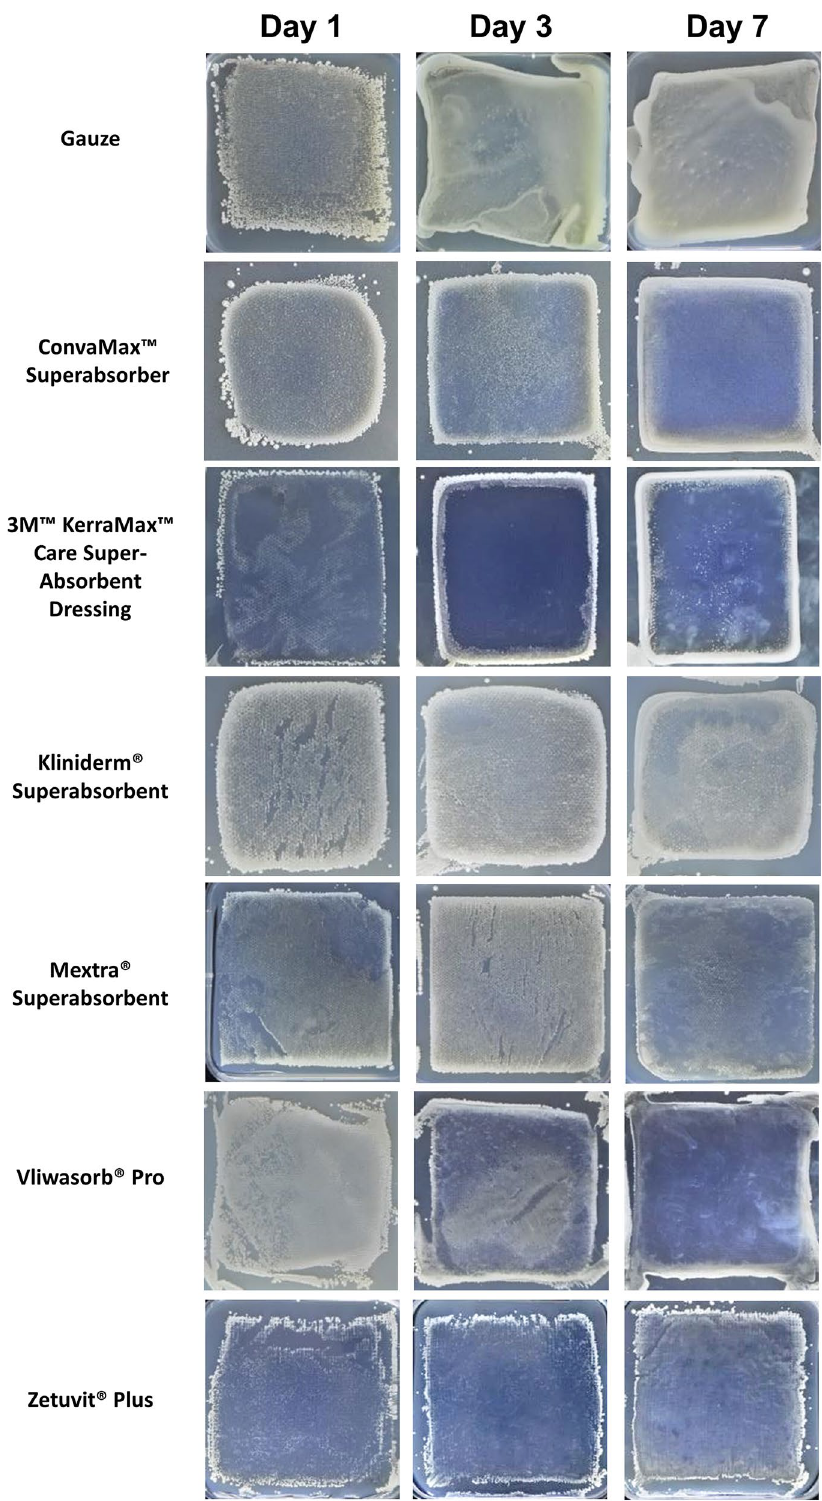
Figure 2. Bacteria transferred to surfaces by superabsorbent dressings. Superabsorbent wound dressings were inoculated with ~ 1 * 10 7 CFU/ml of Staphylococcus aureus daily, over 7 days in triplicate. On 1, 3 and 7 days of inoculation, dressings were transferred to agar and cultured overnight at 37 °C. Dressings were removed and cultured overnight at 37 °C. Plates were imaged for bacterial growth. Representative images for each dressing are displayed. Figure produced in Microsoft PowerPoint